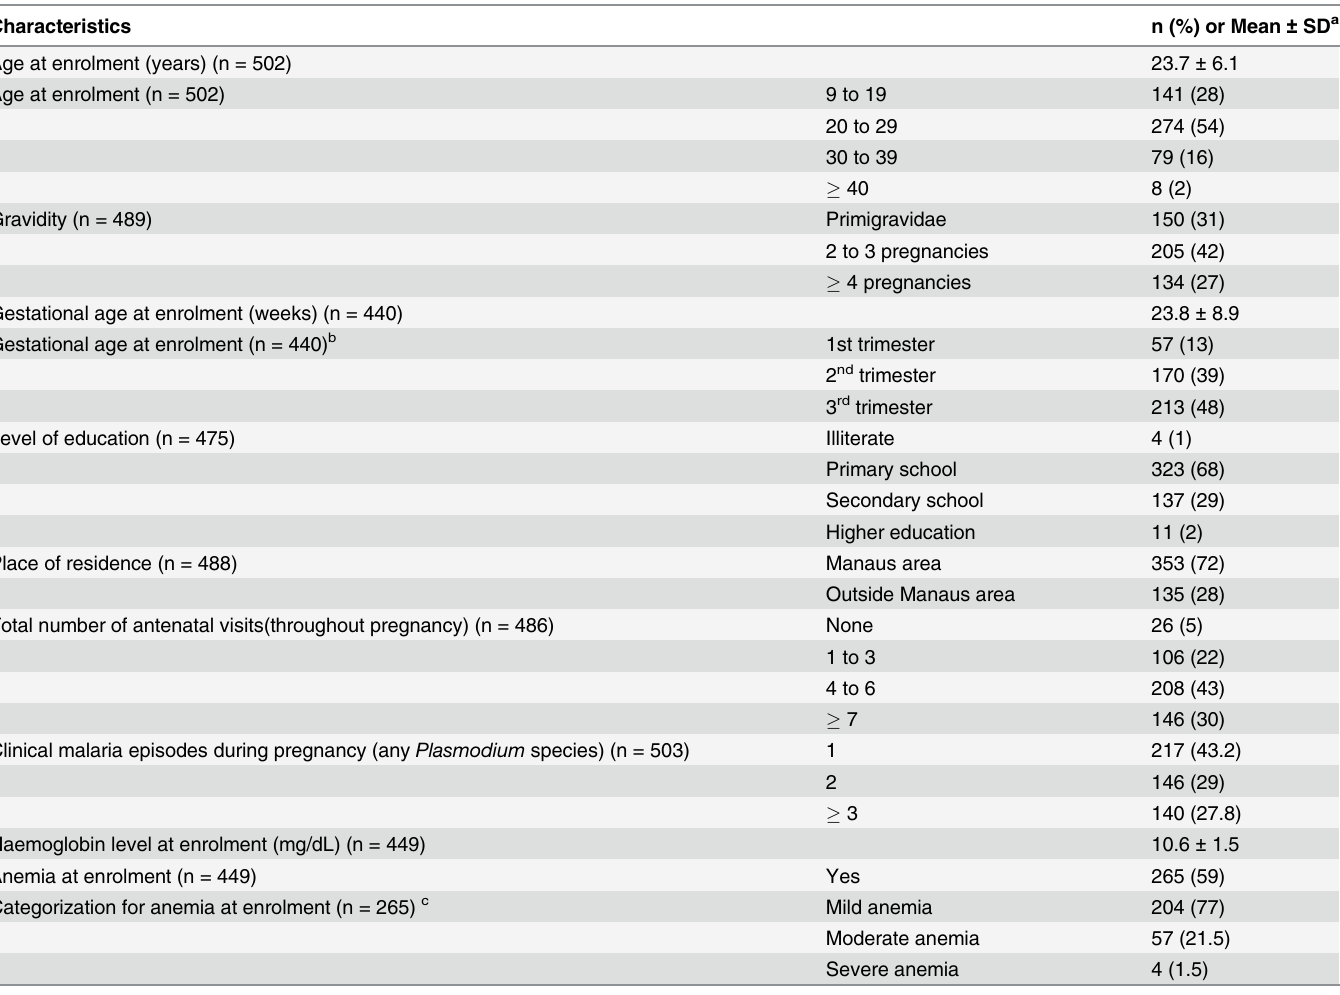
Table 1. Baseline characteristics of study pregnant women.